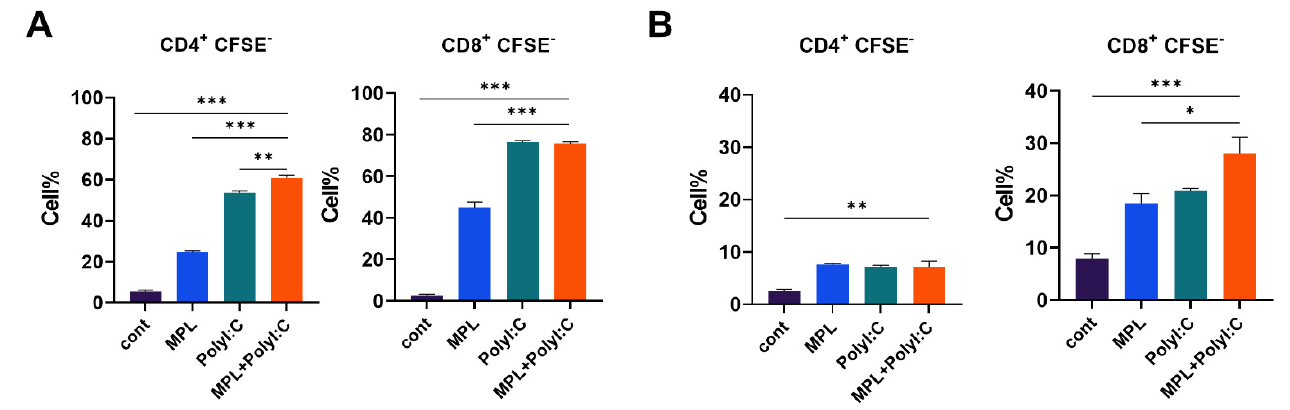
Figure 4. T cell proliferation after co-culture with adjuvant-pre-treated DCs and macrophages. DCs and macrophages generated from bone marrow cells were pre-treated with MPL, Poly I:C, or MPL+Poly I:C for 2 days. Allogeneic lymphocytes were harvested from spleen tissue. CFSE-labeled lymphocytes and pre-activated DCs ( A ) or macrophages ( B ) were co-cultured for 5 days. T cell proliferation was determined by flow cytometry. All results were shown in mean ± SEM. For statistical analysis, One-way ANOVA and Tukey’s post-multiple comparison tests were performed. * p < 0.05; ** p < 0.01; and *** p < 0.001 between the indicated groups.